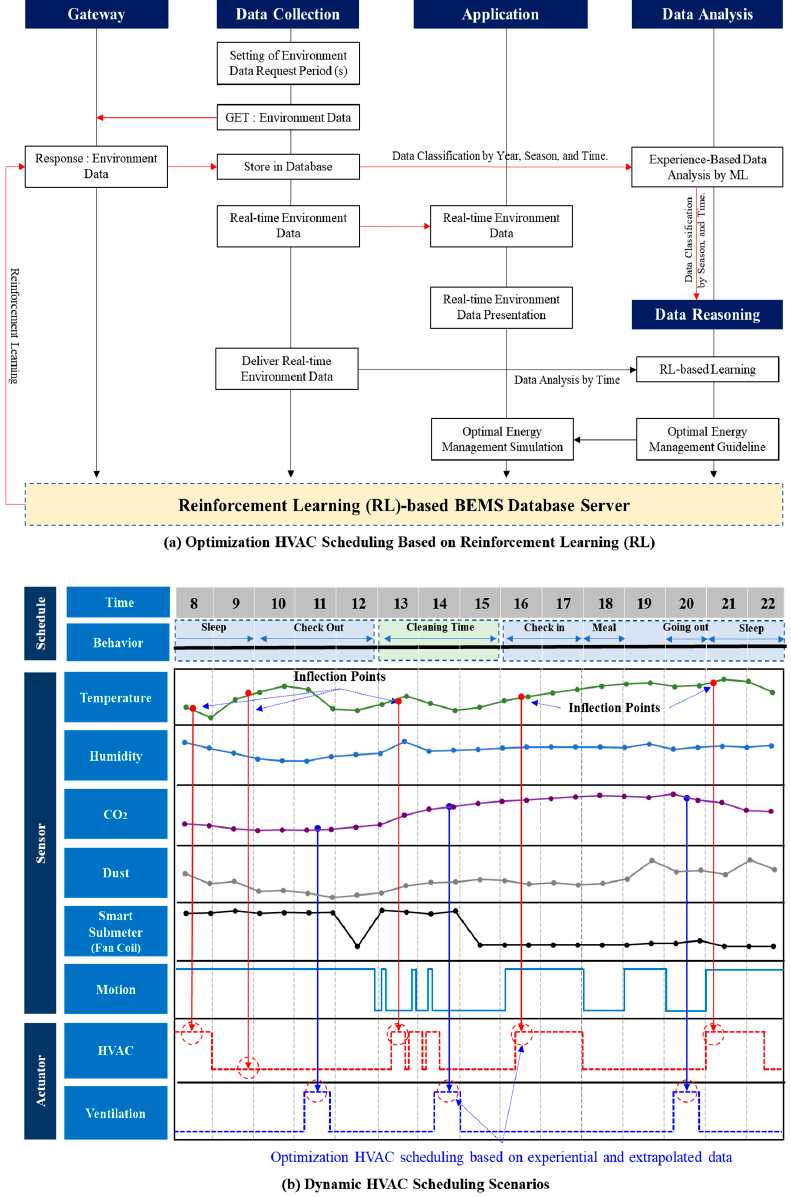
Figure 4. System Flow and Scenarios.